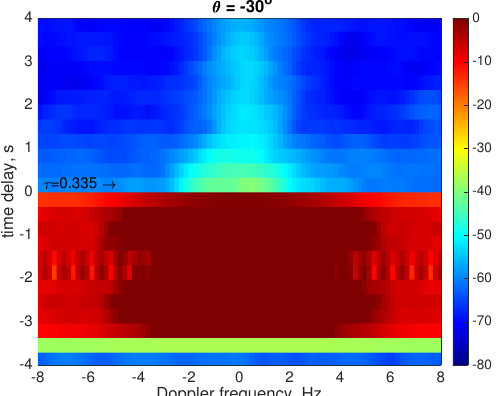
Figure 4. An example of spectrogram of an acoustic signal.